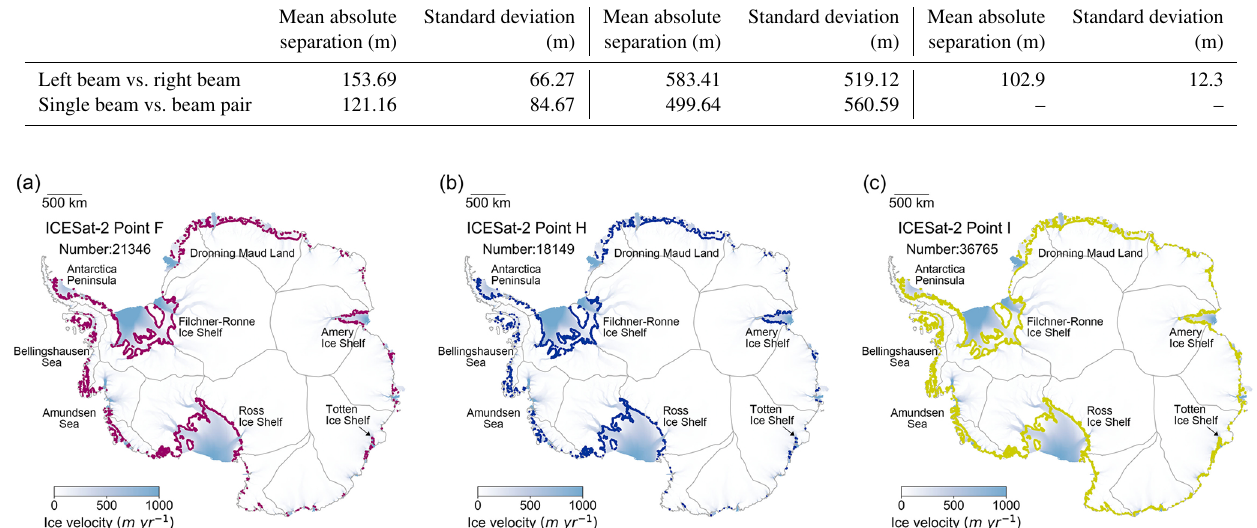
Figure 5. Spatial distributions of ICESat-2-derived grounding zone features of the Antarctic Ice Sheet. (a) ICESat-2-derived inland limits of tidal flexure (Point F; purple dots). (b) ICESat-2-derived inland limit of hydrostatic equilibrium (Point H; blue dots). (c) ICESat-2-derived break in slope (Point I b ; yellow dots). In all subplots, data are superimposed over recent ice velocity magnitudes (Rignot et al., 2017) and IMBIE basin boundary (Shepherd et al., 2018; Rignot et al., 2011b).